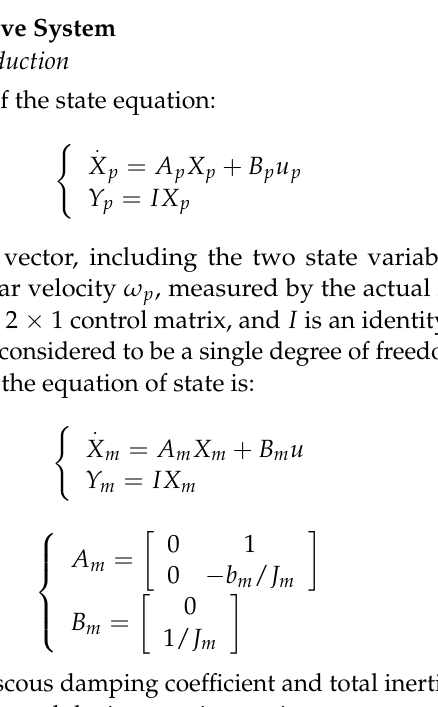
Figure 3. MRAC framework based on PID control.